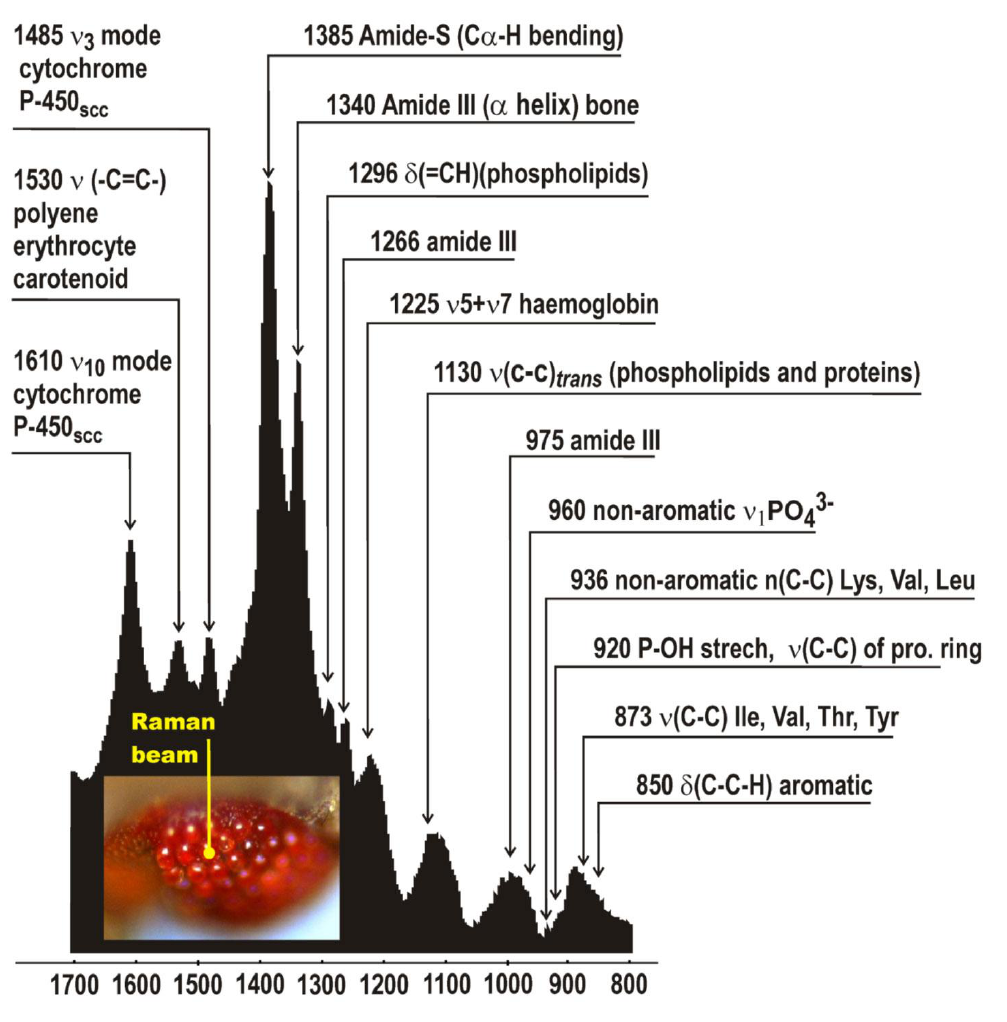
FIGURE 4 . Copium eye ommatidium representative Raman spectrum, including Raman bands (Δcm −1 ) and assignments following the table of Penel et al.[23] for bone, collagen, lipids, and blood to perform node